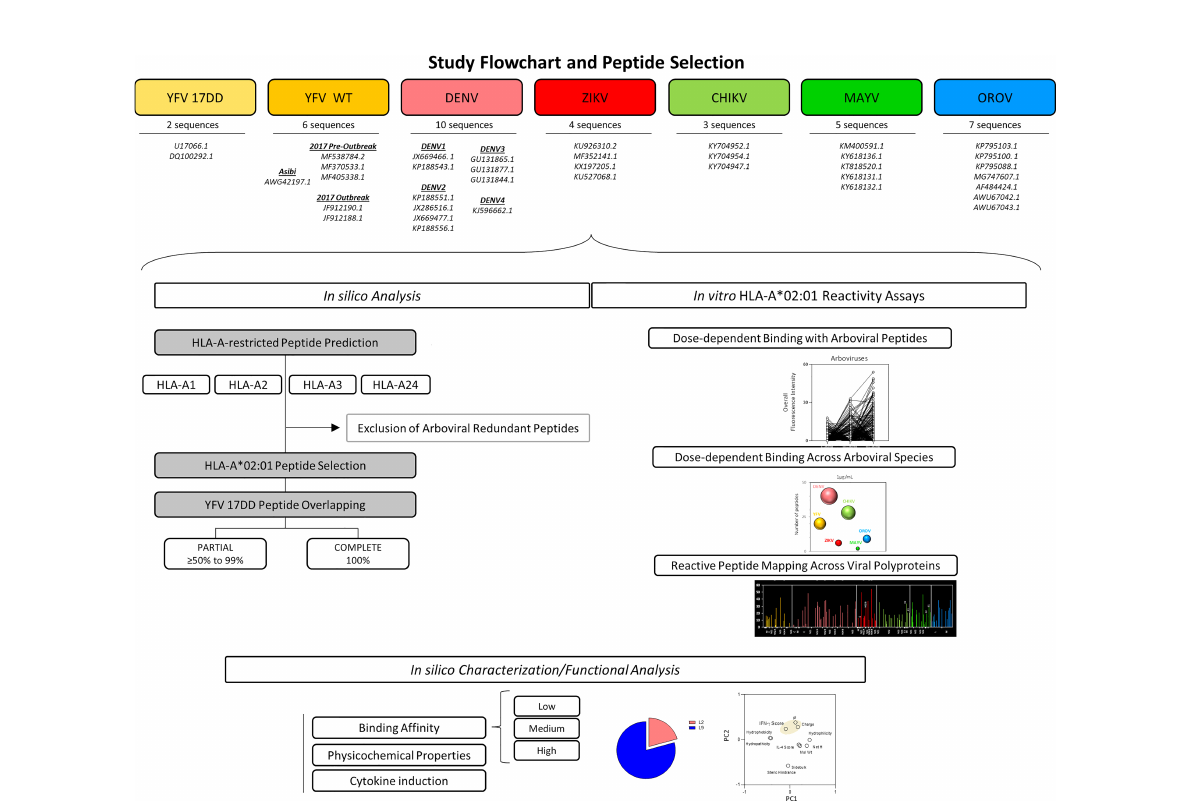
FIGURE 1 Flowchart illustrating Study design and Peptide Selection. Thirty-one sequences comprising 7 arboviruses and 10 serotypes were applied for assessing peptide signatures in silico for HLA-A1, A2, A3 and A24 MHC-I haplotypes. HLA-A*02 restricted-peptides from YFV wild strain, ZIKV, DENV 1-4, CHIKV, MAYV and OROV were selected and assessed for overlapping against YFV-17DD peptides. Biochemical parameters, prediction of IFN- g and IL-4 induction, hydrophobicity, and the frequency of amino acid composition was measured for the identi fi cation of conserved